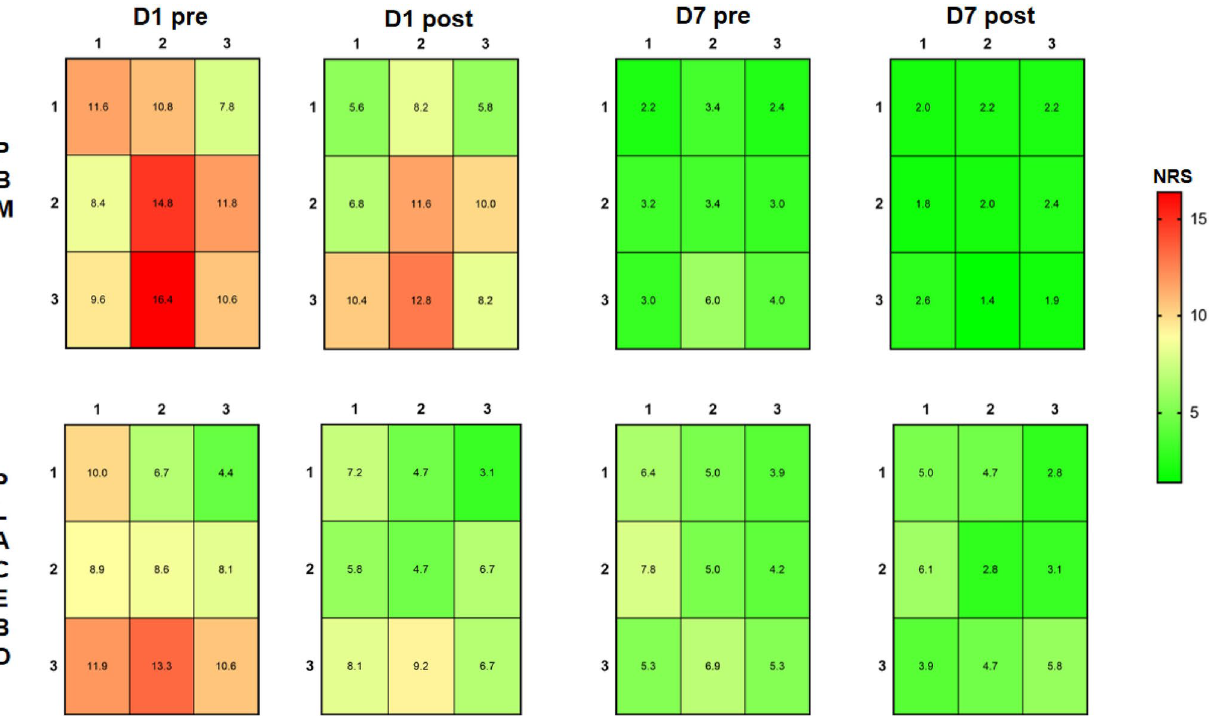
Figure 4. The mechanical sensitivity mapping of TMJ arthralgia patients before and after the treatment with photobiomodulation (PBM) (n = 25) and placebo (n = 25). NRS: numerical rating scale from 0–50–100 with 50 = moderate painful. Measurements were taken before and after treatment at Day 1 and Day 7 (D1 pre / D1 post; D7 pre/D7 post).